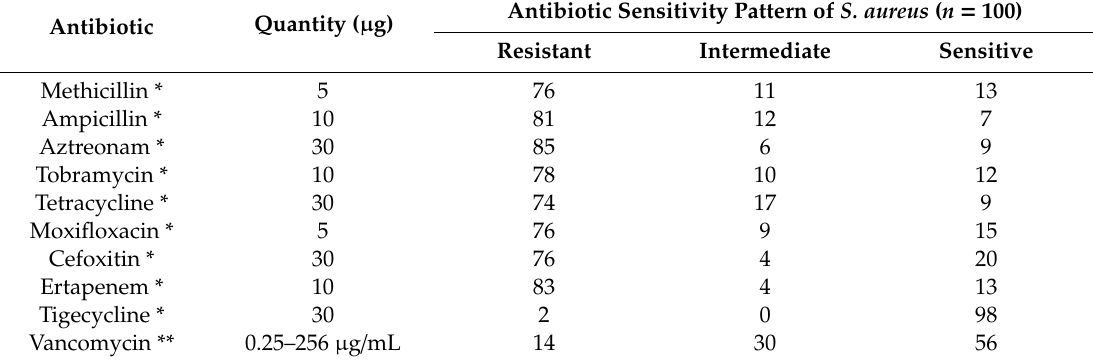
Table 1. Antibiotic sensitivity pattern of Staphylococcus aureus ( n = 100).